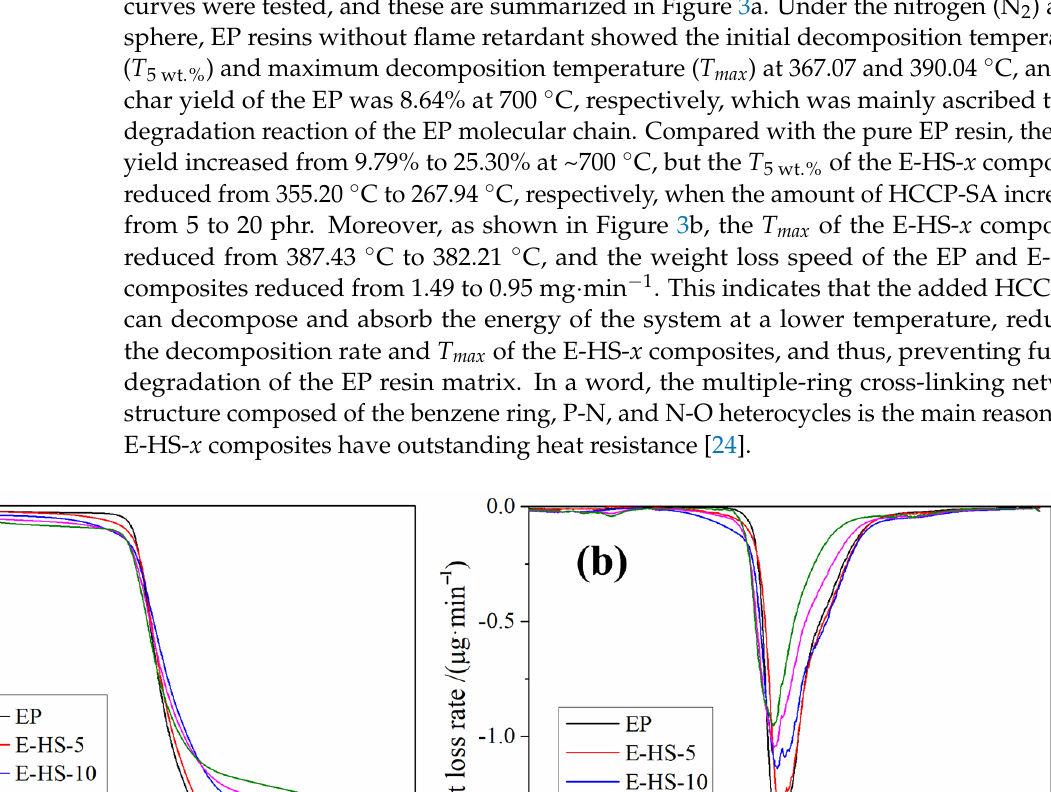
Table 1. Composition of EP and E-HS-x and flame-retardancy data.